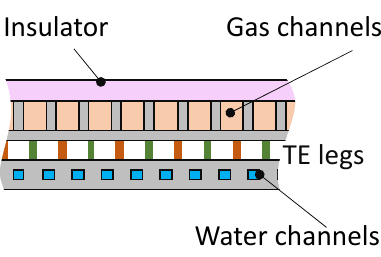
Figure 3. Concept sketch of thermoelectric integrated heat exchanger. The TE legs are n- and p-type semiconductors, located next to each other. They are electrically connected in series and placed thermally in parallel.